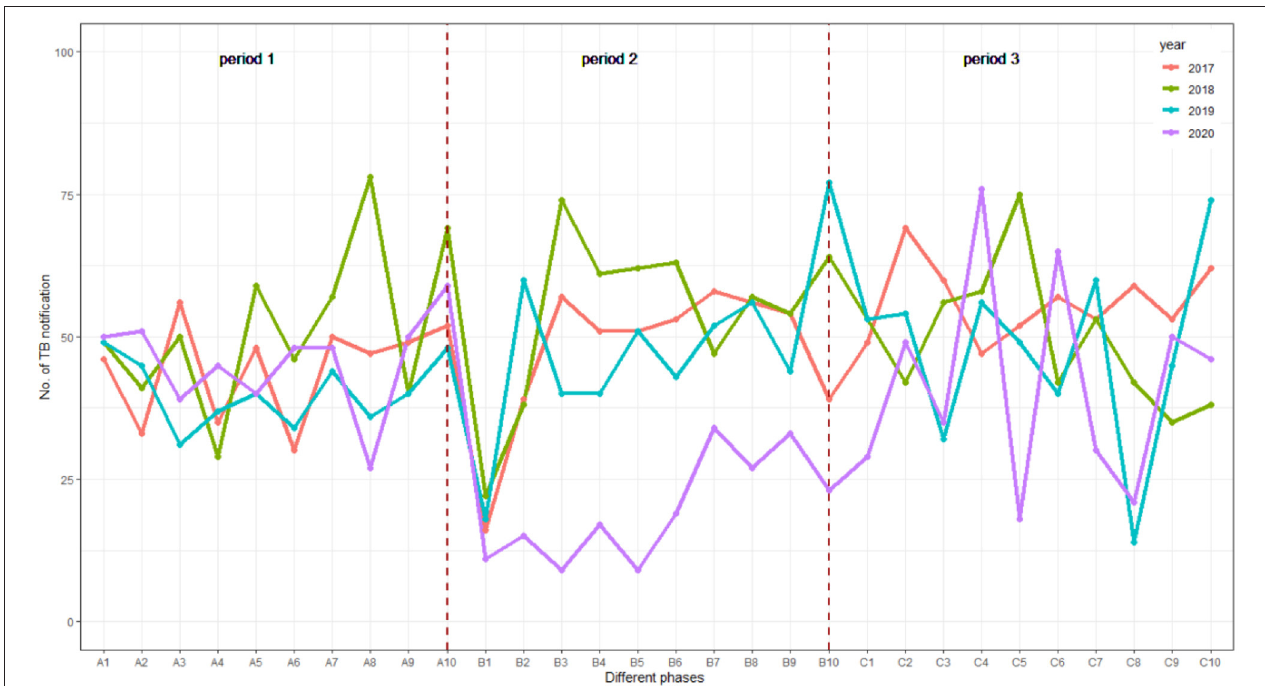
FIGURE 3 | Weekly notification number for TB in 10 weeks before and 20 weeks after the Chinese Spring Festival, 2017–2020 in Ningxia, China.